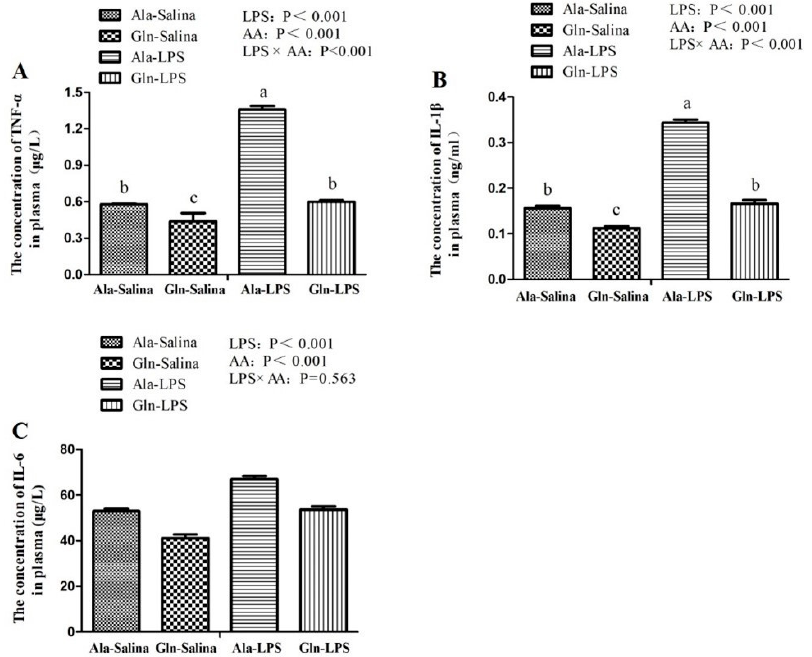
Figure 1. Effects of Gln supplementation on the concentration of tumor necrosis factor- α (TNF- α , ( A )), interleukin-1 β (IL-1 β , ( B )) and interleukin-6 (IL-6, ( C )) in plasma of broilers following treatment with LPS or saline. Values are means ± SEM n = 10 (10 chicken per treatment). The significant difference is indicated by p <